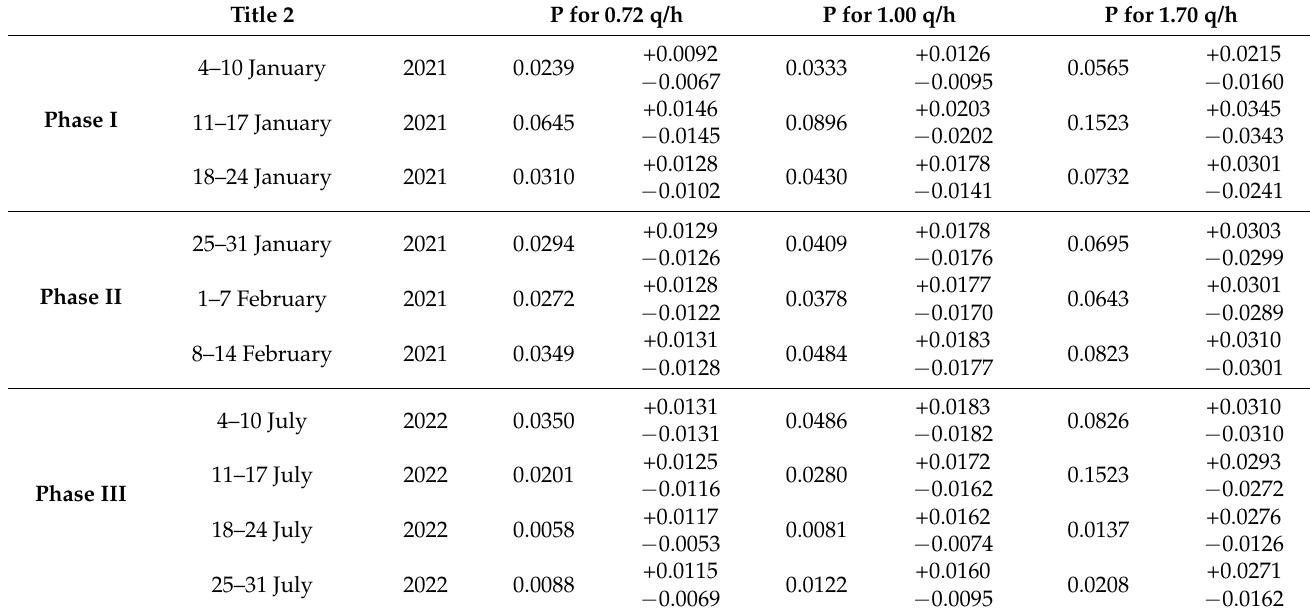
Table 7. Summarize the output of the performed analysis in Phases I, II and III.